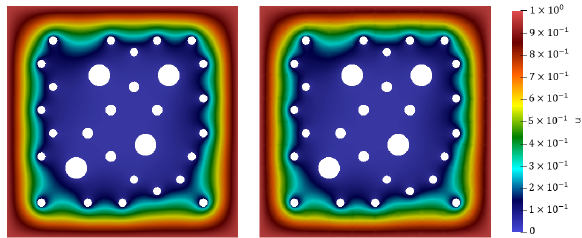
Figure 9. Elliptic problem with α = 100. Case 1 (homogeneous boundary conditions). Left : Reference solution ( DOF h = 85,230). Right : Multiscale solution with 12 multiscale basis functions, e L 2 = 1.053 ( M g = M = 12, M p = 0, DOF H =